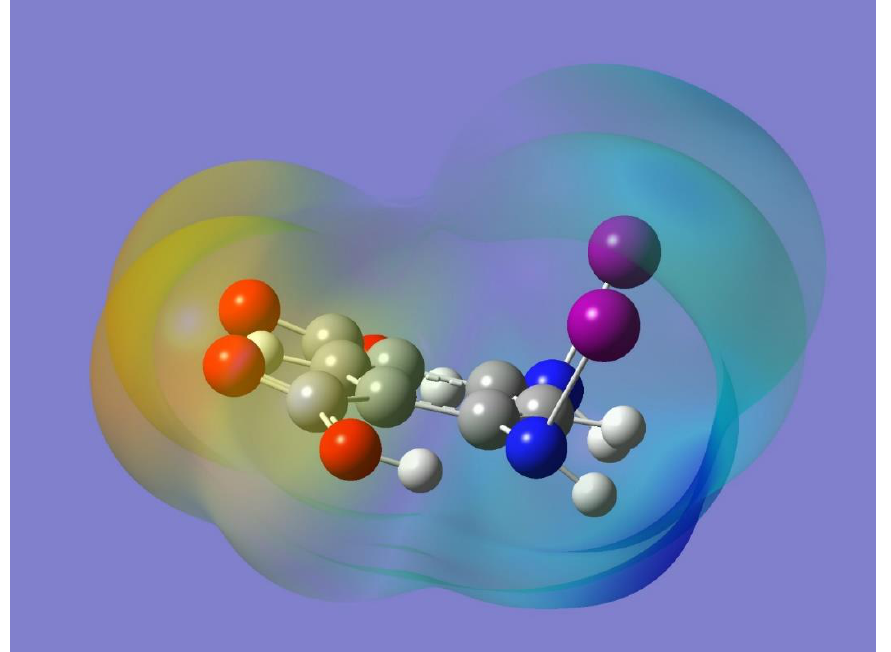
Figure 2. Electrostatic potential on the 0.001-au molecular surface of the optimized model system, ((HOOC) 2 -C 6 H 2 -(NHI) 2 ). Yellow-red represents the most negative electrostatic potential and blue the most